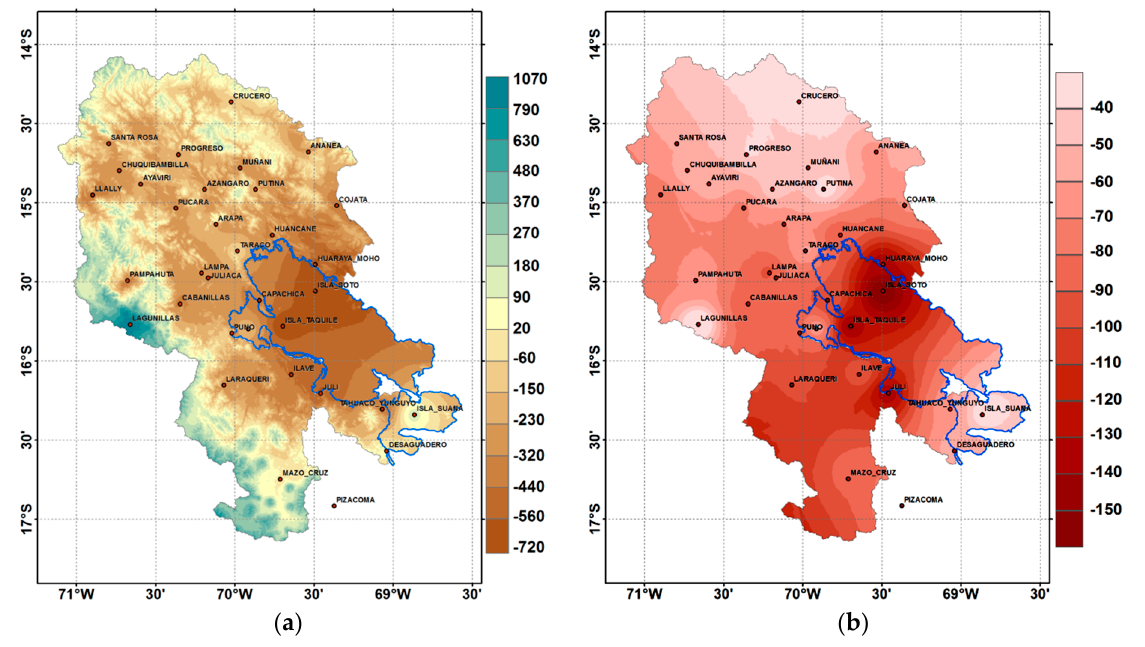
Figure 7. Bias spatialization map for the annual precipitation cycle ( a ) and for the summer precipitation ( b ). Period 2002–2013. Scale in colors represents the underestimation or overestimation of CMORPH compared to RgSENAMHI.